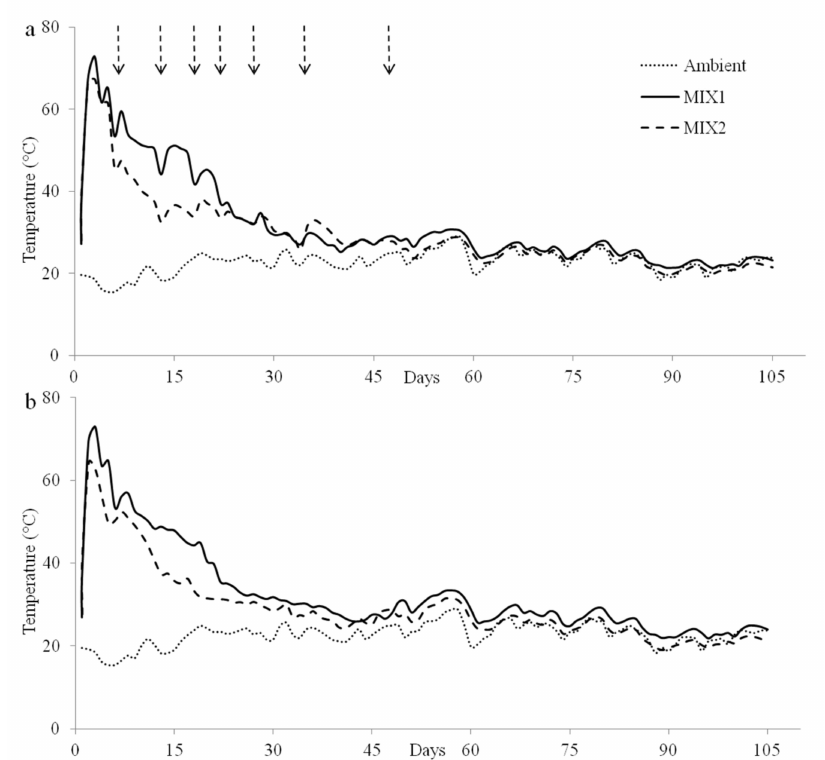
Figure 1. Average ambient temperature (Ambient) and temperatures development of the two investigated mixtures (MIX1: Brewers’ Spent Grain + Wheat Straw + Pig slurry Solid Fraction; MIX2: Brewers’ Spent Grain + Wheat Straw + Sheep Manure) with different composting strategies: (MT) manual turning ( a ) and (ST) static composting – without turning operations ( b ). In MT strategy, arrows mark the time of